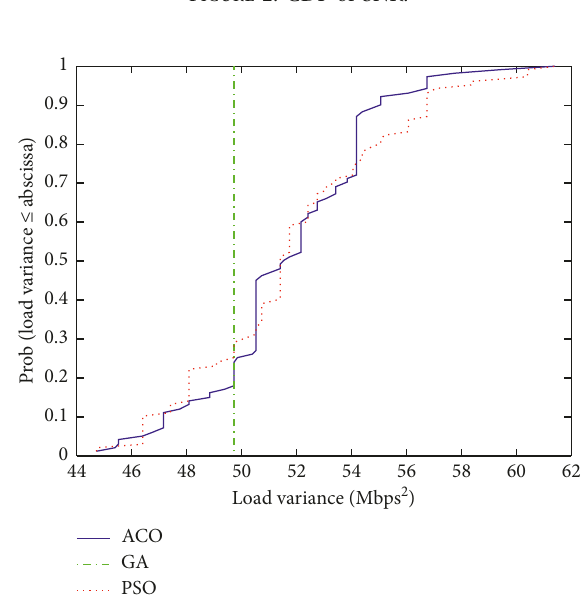
Figure 2: CDF of SNR.